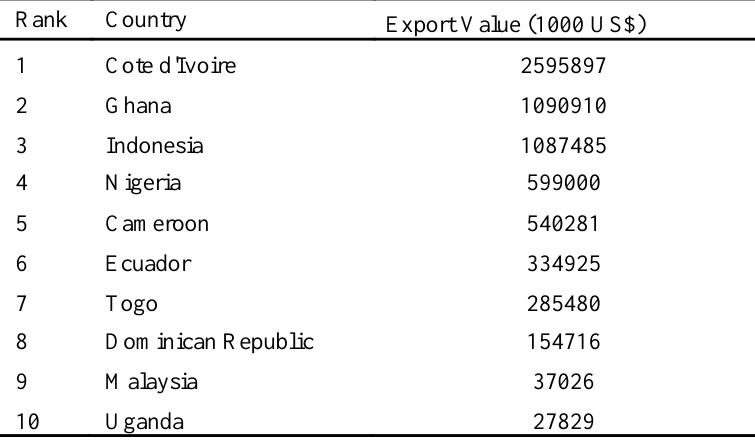
Table 1 . Top 10 Cocoa Bean Exporting Countries in 2009 by Export Value